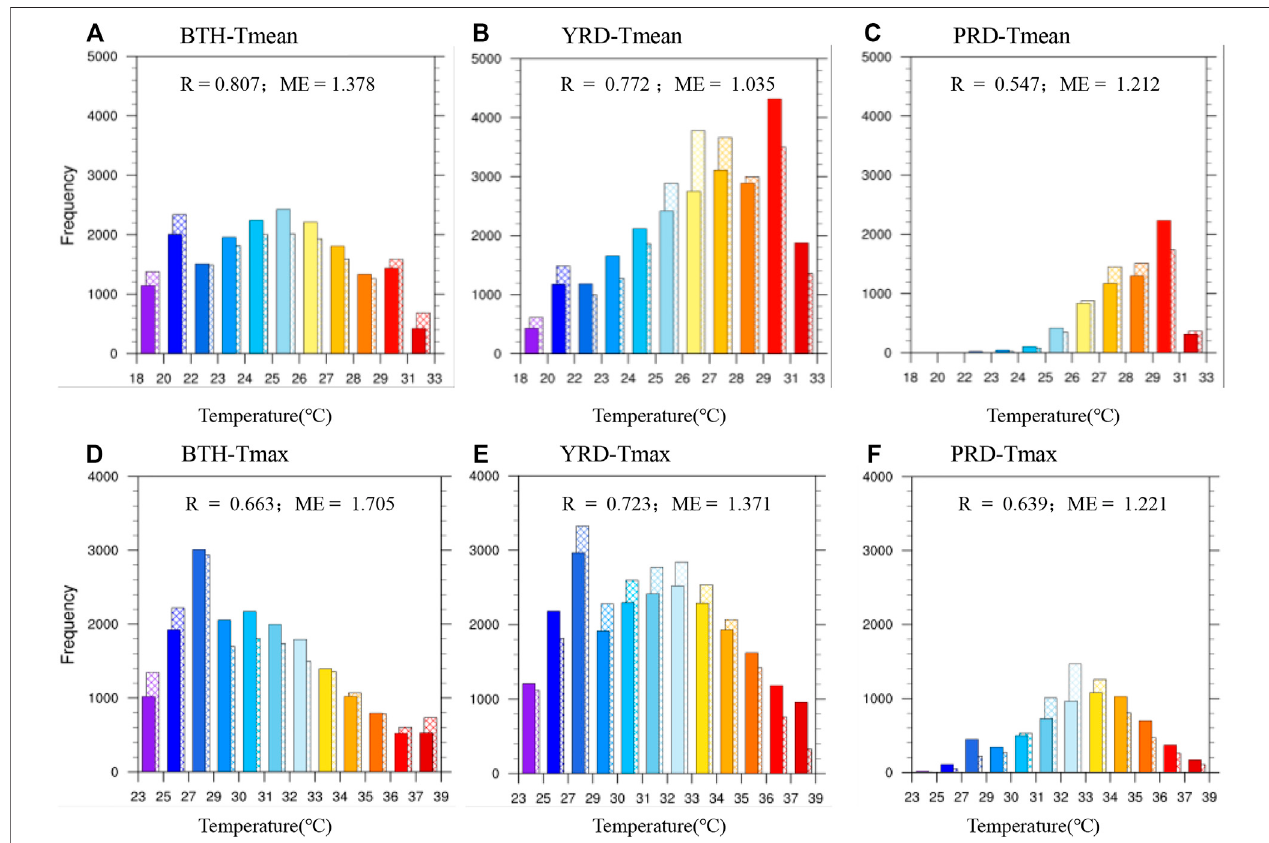
FIGURE 3 | Frequency comparison histogram of T mean and T max between observation data and WRF simulation results during the entire analysis period (JJA of 1996 – 2005) over (A , D) BTH, (B,E) YRD, and (C,F) PRD (solid color represents observation data, and grids represent WRF simulation results; R represents the correlation coef fi cients, and ME represents the mean